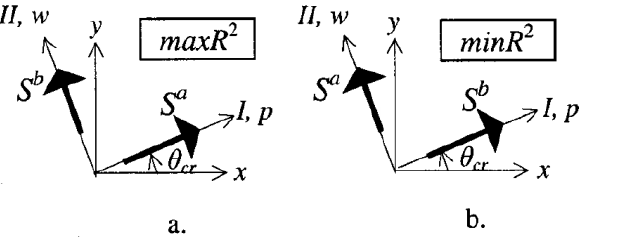
Figure 1. Reference system; ( a ) maximum reactions; ( b ) minimum reactions [22]. In Equations (10) to (12), (cid:2013) represents the correlation coefficients between the (cid:3036)(cid:3037)